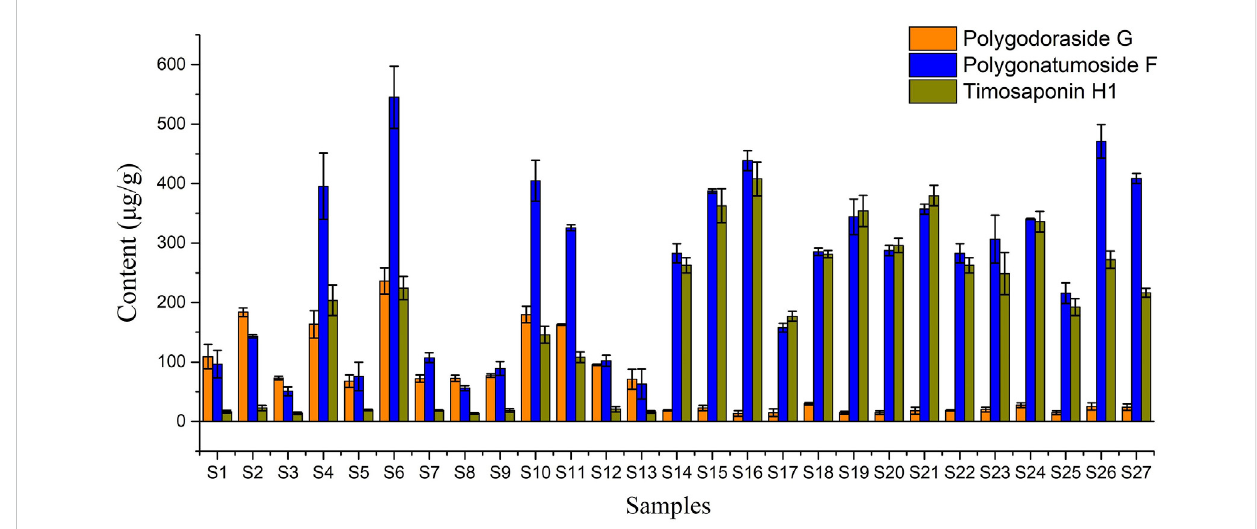
Contents of the three compounds in 27 batches of PO.